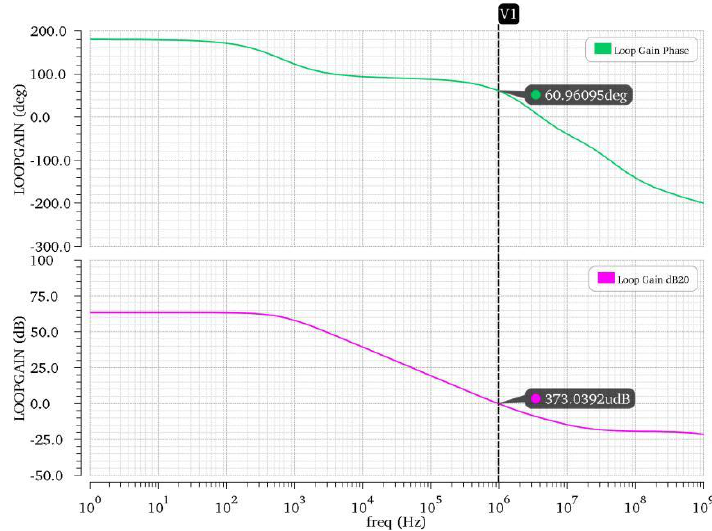
Figure 6. Simulated loop response in Figure 5: Phase response and gain response (VDD = 1.2 V).